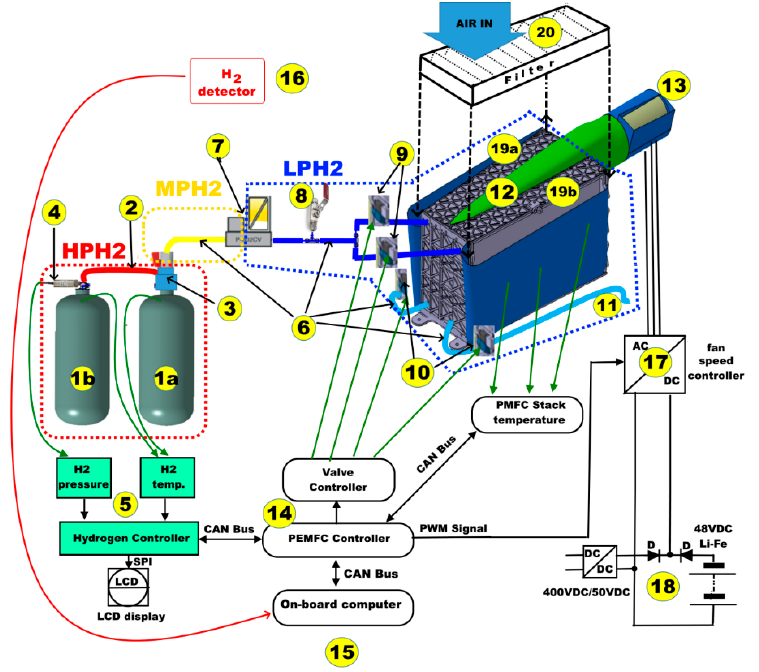
Figure 1. The concept of a polymer exchange membrane fuel cell (PEMFC) stack with the balance of the fuel cell power plant .